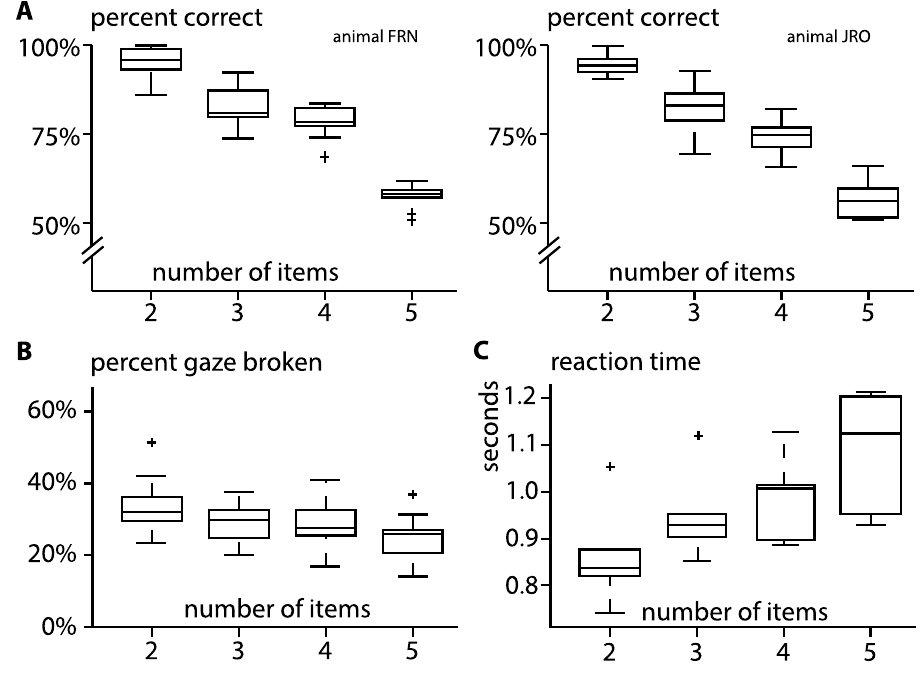
Figure 2. Crows’ performance is modulated by number of items in WM. All box-plots display median, 25 th and 75 th percentile, whiskers display the full extent of the data, crosses indicate outliers. (A) Performance of each animal on attempted trials as a function of number of items in stimulus-array (mean performance animal FRN 2: 94%, 3: 82%, 4: 74%, 5: 56%; animal JRO 2: 95%, 3: 82%, 4: 78%, 5: 57%). (B) Percent gaze-breaks of both animals on started trials as a function of number of items in stimulus-array (mean 2: 34%, 3: 29%, 4: 29%, 5: 24% ) . (C) Reaction time of both animals on correct trials as a function of number of items in stimulus-array